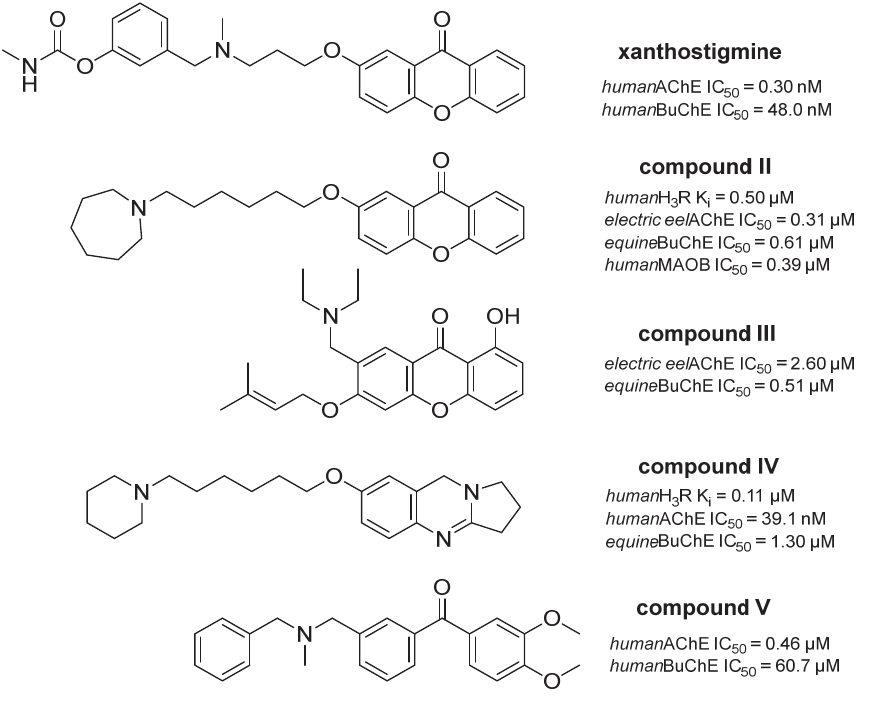
Figure 2. Xanthone, benzophenone and basic tertiary amine motifs present in compounds developed as potential AD therapeutics [13,32,36,37,40].